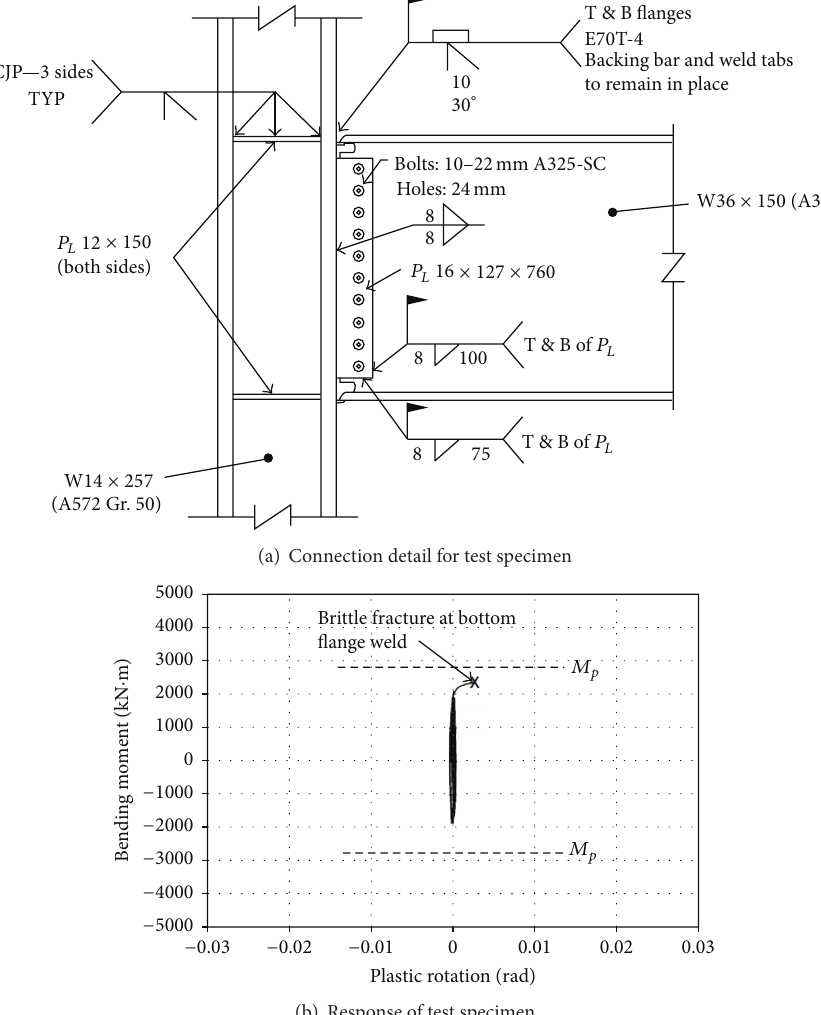
Figure 1: Example of experimental response of pre-Northridge connections.